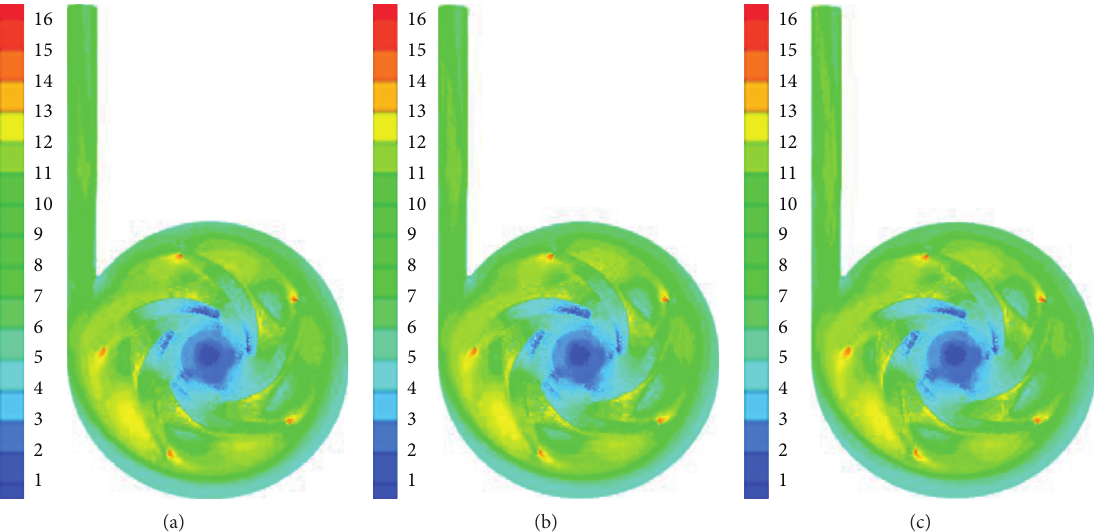
Figure 9: Cloud diagram of centrifugal pump velocity at different concentrations ( d � 0.1mm): (a) C